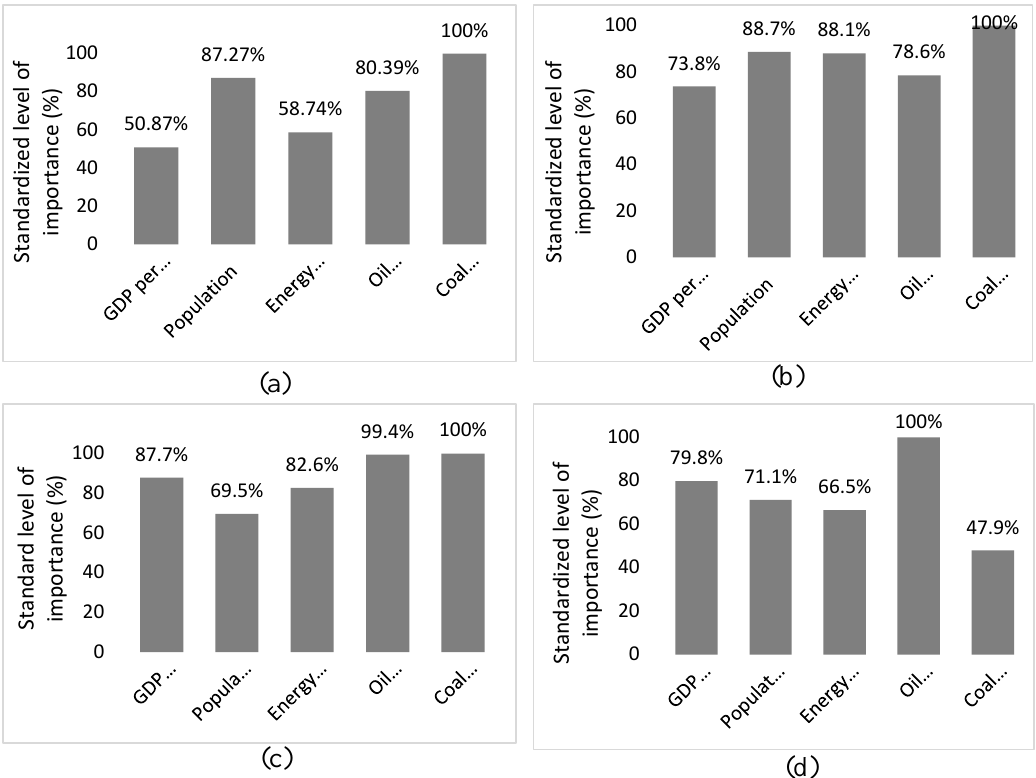
Figure 9. The level of importance of the input variables on the predicted CO 2 emissions in ( a ) Malaysia, ( b ) Thailand, ( c ) Indonesia, ( d ) Philippines.